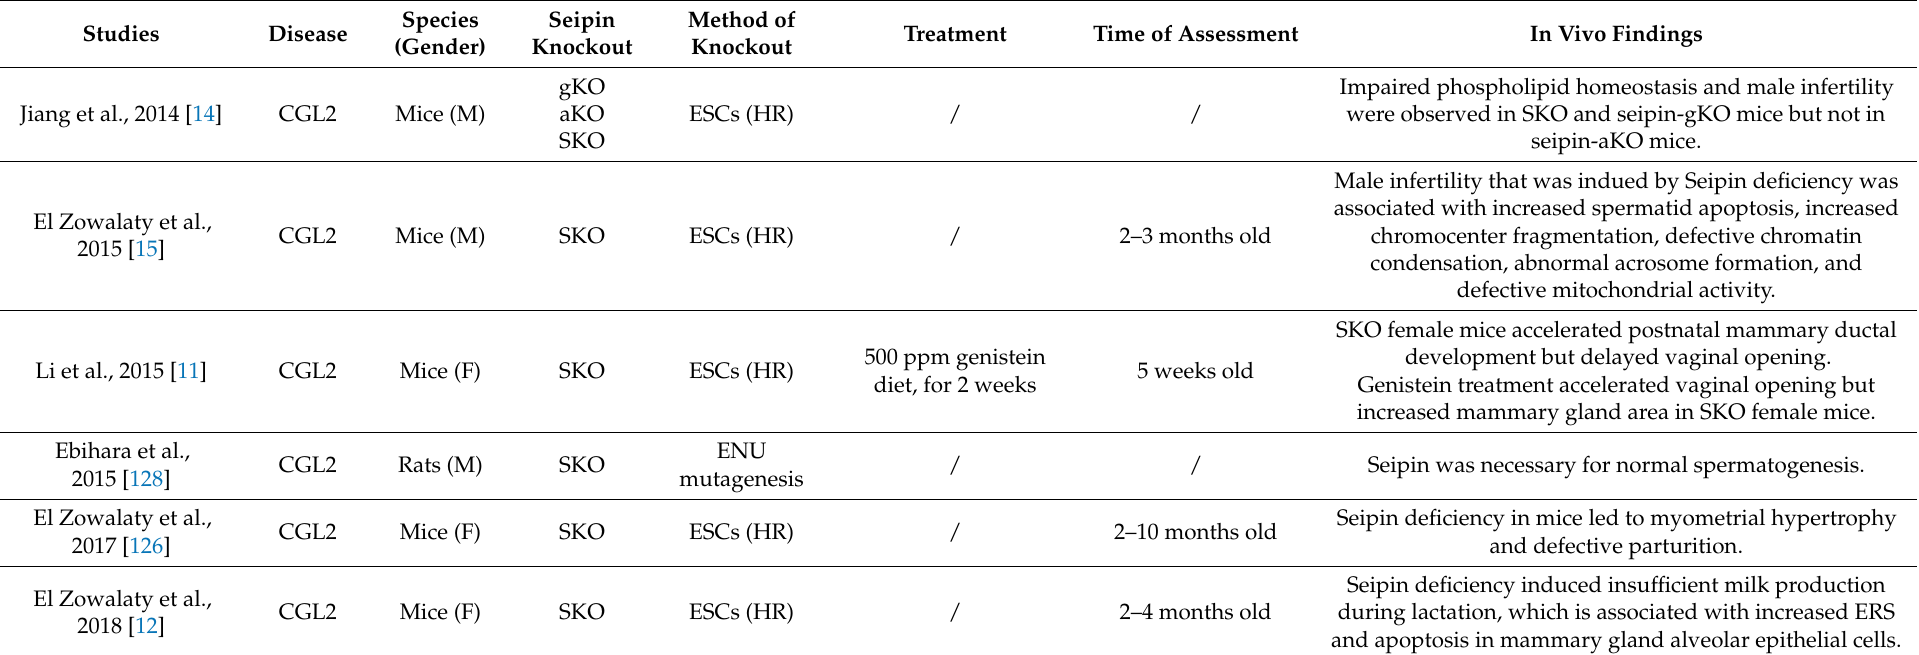
Table 6. Reproductive system disorders of seipin deficiency or overexpression in